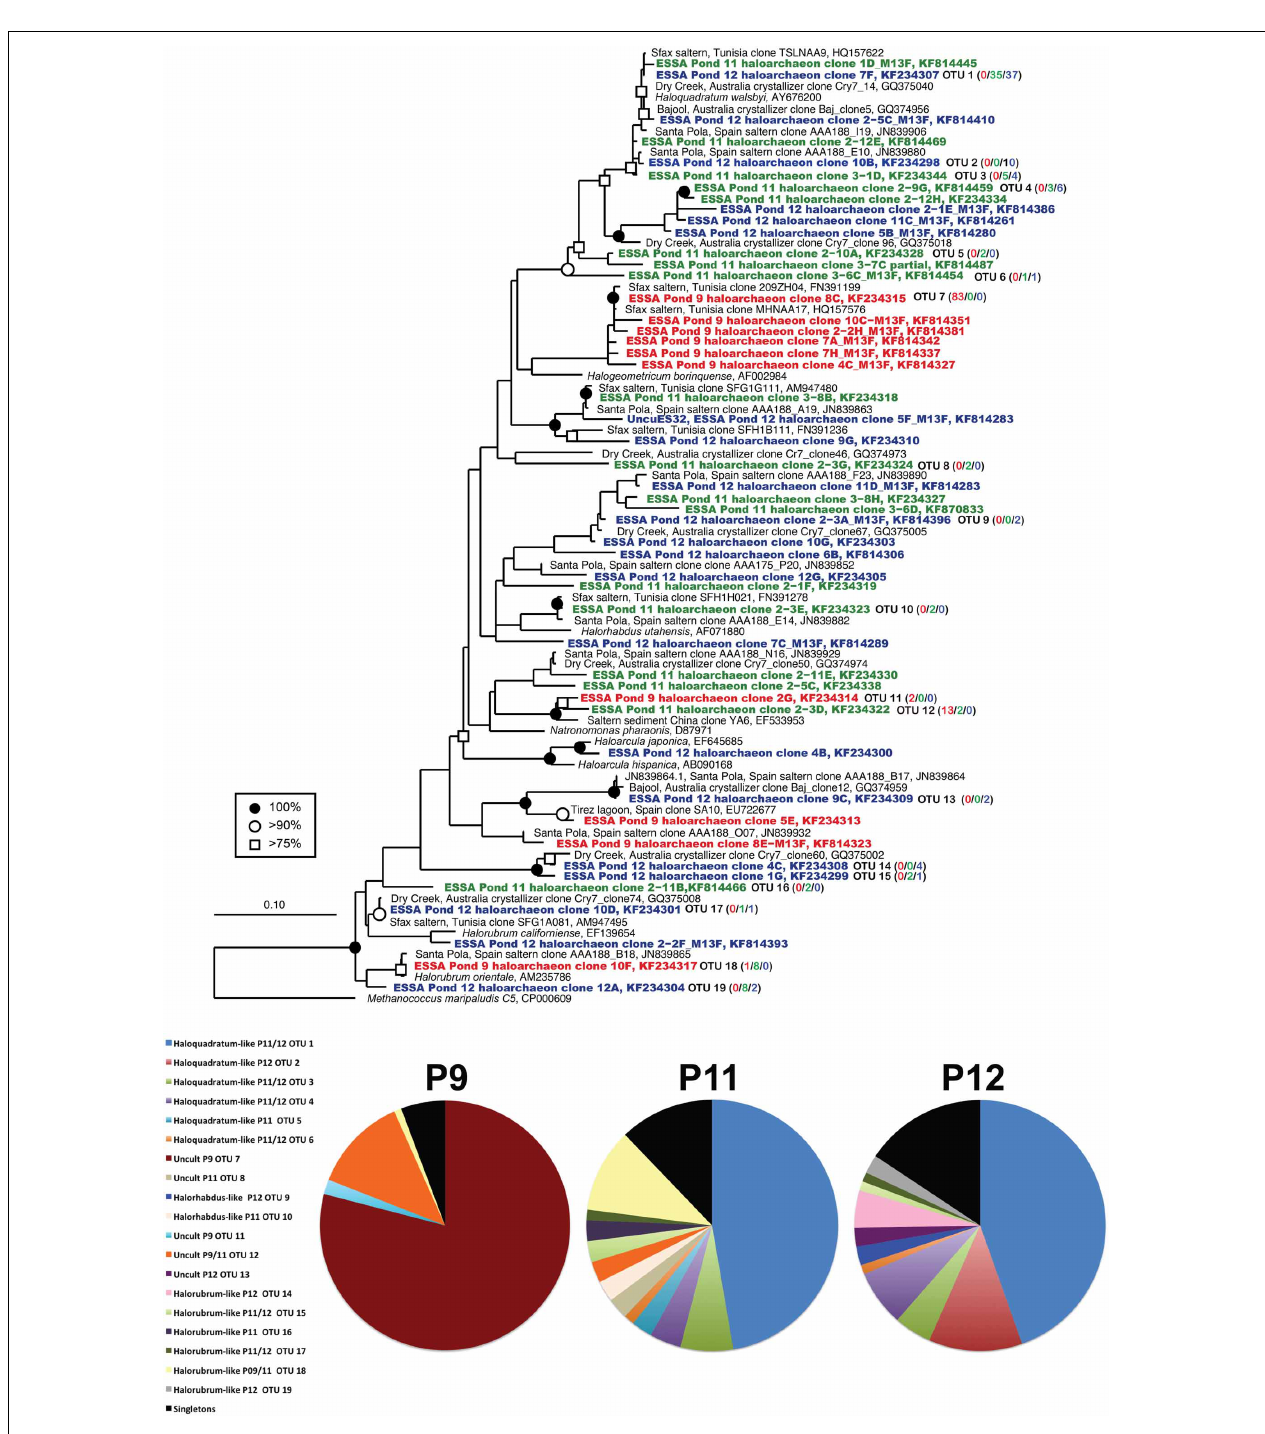
likelihood trees (750 replicates). Partial ESSA sequences labeled with M13F/R and short Santa Pola saltern sequences (accession = JN839XXX) were added using the parsimony addition tool in ARB. For OTU ( ≥ 99% similarity) containing more than 1 sequence, the number of duplicates from each pond (9/11/12) is shown in parentheses. Methanococcus maripaludis was used as the outgroup. Pie charts show the relative representation of each of the identified OTUs for each pond, with those found only once (singletons) grouped. Legend is for all three charts.